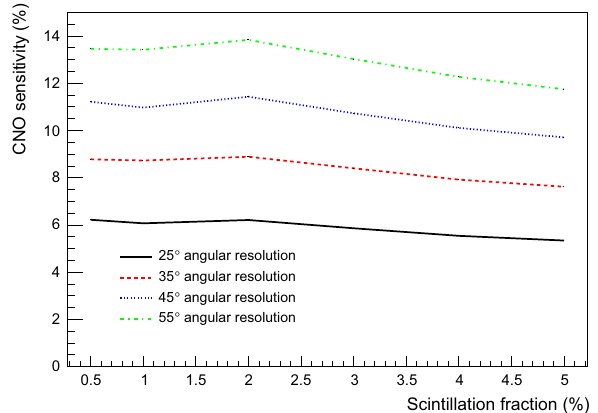
Fig. 7 CNOsensitivityasafunctionofscintillatorfractionandangular resolution for a 50 kT detector after 5 years of running with the baseline background assumptions